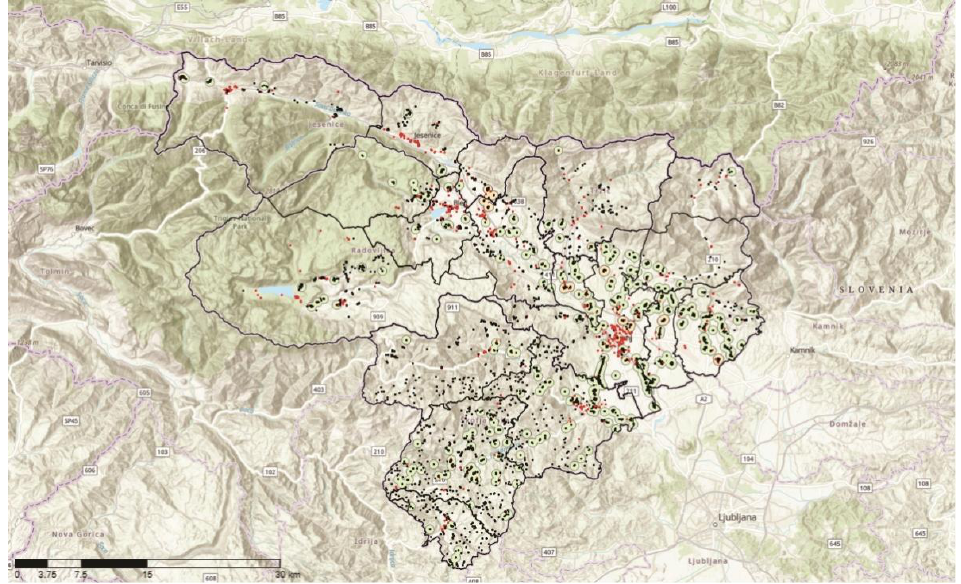
Figure 6. Food waste, waste oil and LU clusters.